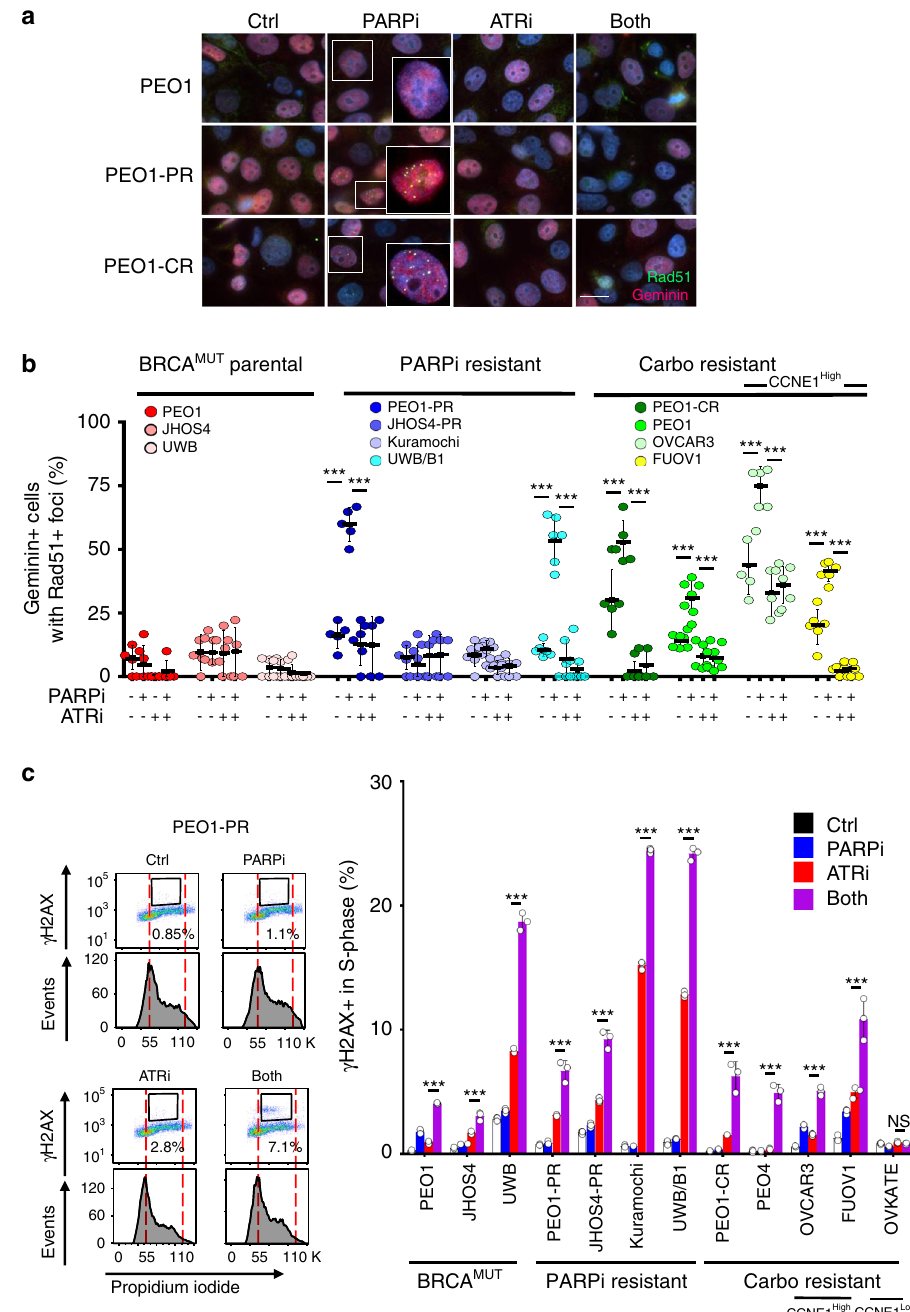
Fig. 4 Drug effects on homologous recombination and DNA double-strand breaks. a – c Parental BRCA MUT ( BRCA2 MUT PEO1; BRCA1 MUT JHOS4, UWB), PARPi-resistant (PEO1-PR, JHOS4-PR, Kuramochi, UWB/B1 where B1 denotes BRCA1 + / − ), and platinum-resistant (PEO1-CR, PEO4; CCNE1 Amp OVCAR3, FUOV1) were treated with PARPi (1 μ M), ATRi (1 μ M), or combination for 24 h. a , b RAD51 (green) nuclear foci were detected in geminin positive (red) cells by immuno fl uorescence staining. Magni fi cation is ×60 for large panel and ×100 for insert. Scale bar = 20 μ m. b Cells with >5 foci in the nucleus were counted as a positive RAD51 cell. Each dot represents the mean number of events per high-power fi elds ( n = 5 fi elds) with mean ± SD shown. RAD51 in PARPi group was higher than control for PEO1-PR ( P < 0.0001), UWB/B1 ( P < 0.0001), PEO4 ( P < 0.0001), FUOV1 ( P < 0.0001), PEO1-CR ( P = 0.002), and OVCAR3 ( P = 0.0003) lines, and RAD51 in PARPi – ATRi treatment group was lower than PARPi monotherapy for these cell lines ( P < 0.0001). c Detection of γ H2AX-positive cells in S phase of PARPi – ATRi-treated parental BRCA MUT , PARPi-resistant, and platinum-resistant cells. Cells were treated with 1 μ M PARPi, 0.5 μ M ATRi or combination, and JHOS4-PR and OVCAR3 were treated with 1 μ M PARPi, 1 μ M ATRi, or combination. After treatment for 24 h (JHOS4-PR 36 h), cells were fi xed and stained with γ H2AX and PI for fl ow cytometry, and γ H2AX-positive cells in S phase were quanti fi ed. Representative images of PEO1-PR cells (left) and quanti fi ed data (right) were shown. γ H2AX-positive cells in PARPi – ATRi group was higher than ATRi monotherapy for all cell lines (JHOS4, P = 0.0003; FUOV1, P = 0.0002; and remaining cells, P < 0.0001) except OVKATE, P = 0.3703). Data shown is mean ± SD ( n = 3 biologically independent samples). Individual samples are presented as data points. Data was analyzed by one-way ANOVA test followed by Tukey ’ s multiple-comparisons test; *** P < 0.001, NS = not signi fi cant. Source data are provided as a source data fi